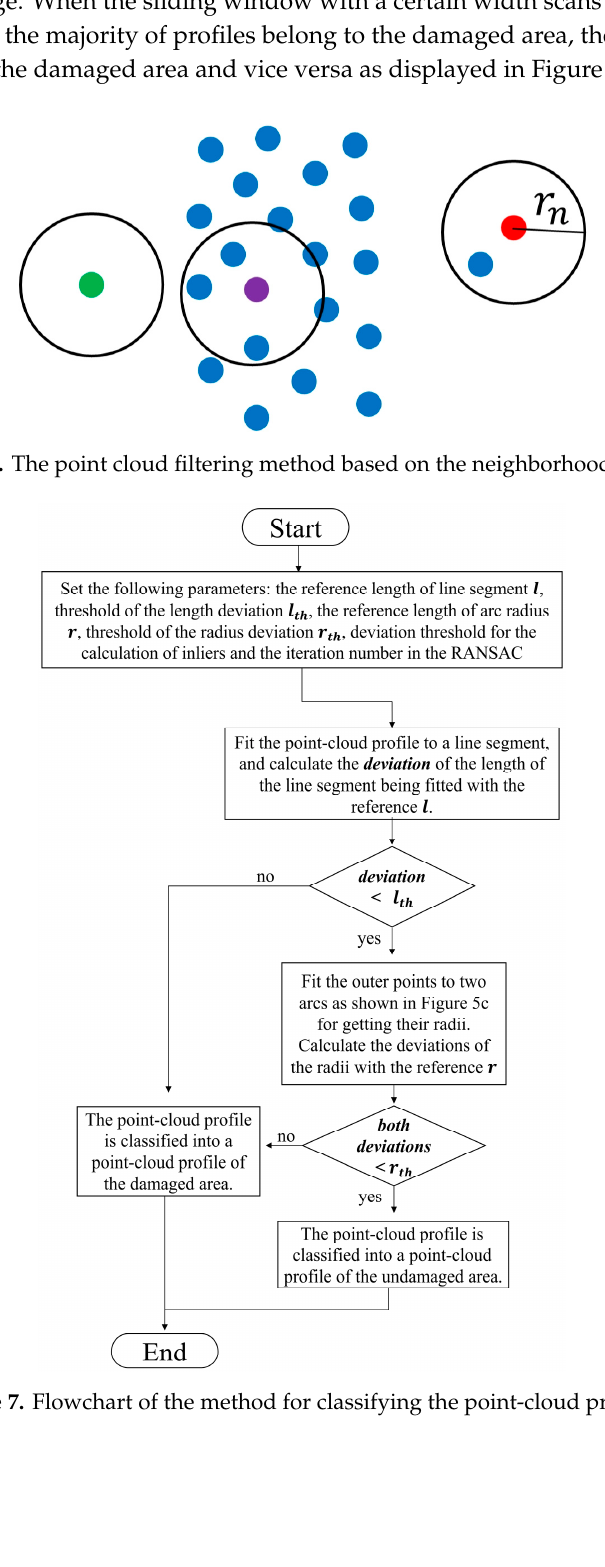
Figure 7. Flowchart of the method for classifying the point-cloud profiles.